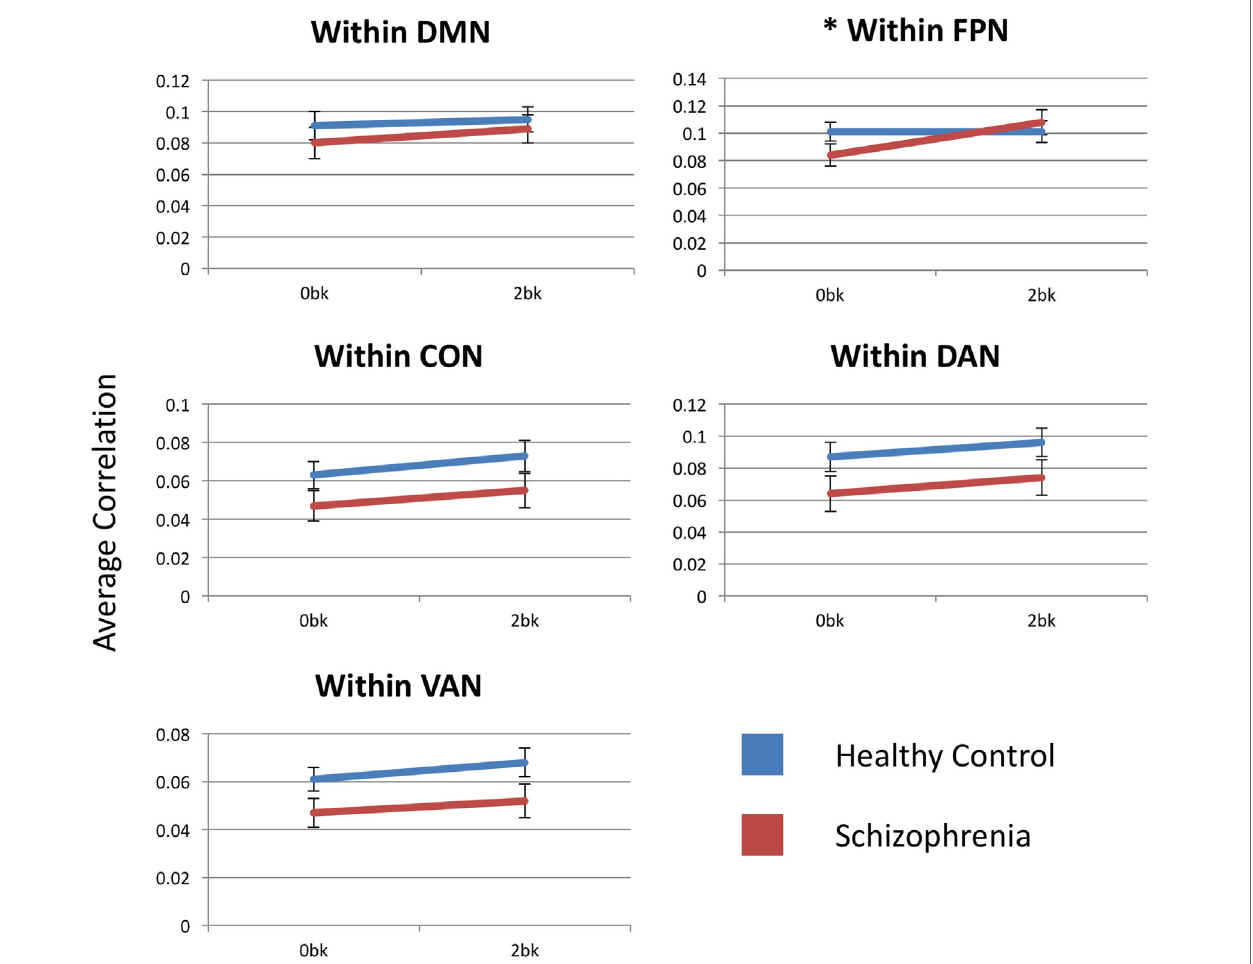
FigUre 3 | Within-network functional connectivity for the five networks assessed. Each graph presents the average within-network correlation coefficients ( y -axis) for each network. Only the frontoparietal network showed a significant interaction between diagnostic group (Control vs. Schizophrenia patients) and n -back (0-back vs. 2-back). DMN, default mode network; FPN, frontoparietal network; CON, cingulo-opercular network; DAN, dorsal attention network; VAN, ventral attention network. Asterisks indicate statistical significance ( p = 0.05) for group × condition effect. Error bars represent